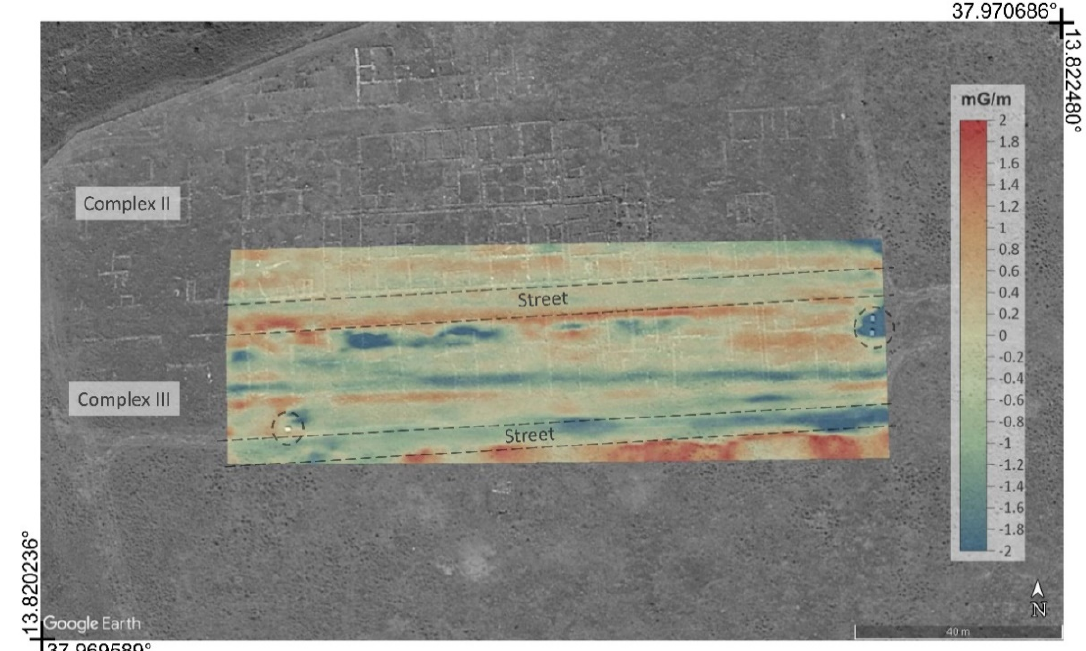
Figure 9. Overlay of the map of the residual magnetic anomaly with an aerial Google Earth image, the circle dots indicate the tourist information board. Units in milligauss/m.